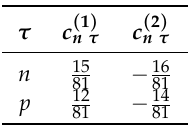
( α ) n τ in spin-flavor-color space. These coefficients entail